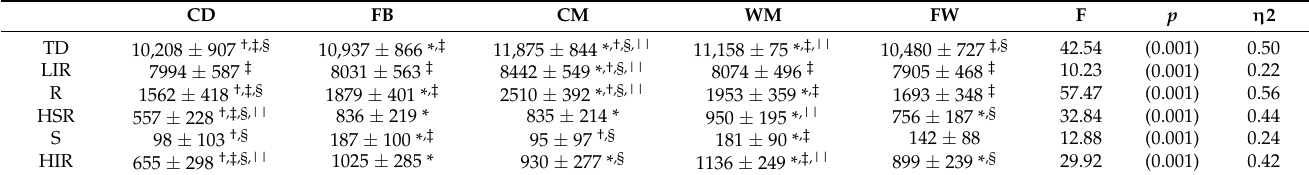
Table 1. Descriptive statistics and differences in running performances among players at different playing positions (data are given as Mean ± SD in